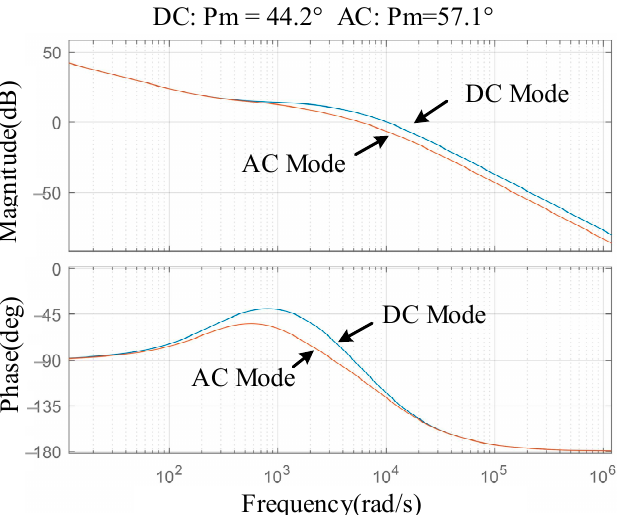
Figure 11. Control part Bode diagram.